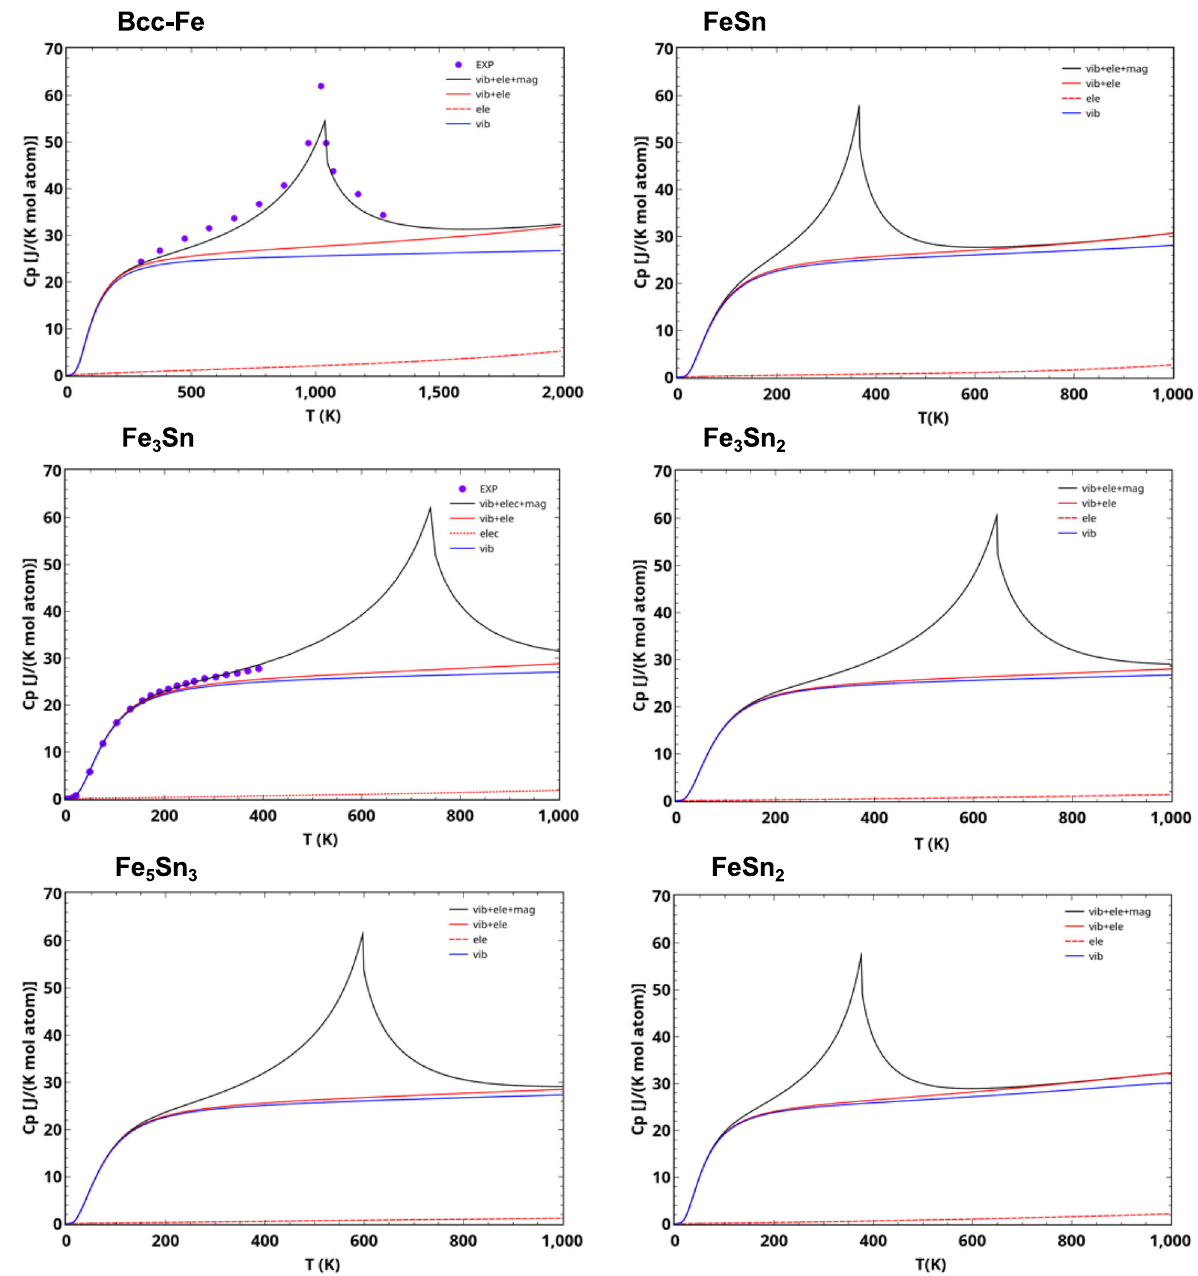
Fig. 2 Heat capacity of pure Fe and Sn from DFT calculations in comparison with the experiment data 37 . Those for all the intermetallics are also shown, experimental data of Fe 3 Sn is obtained from our previous studies 32,33